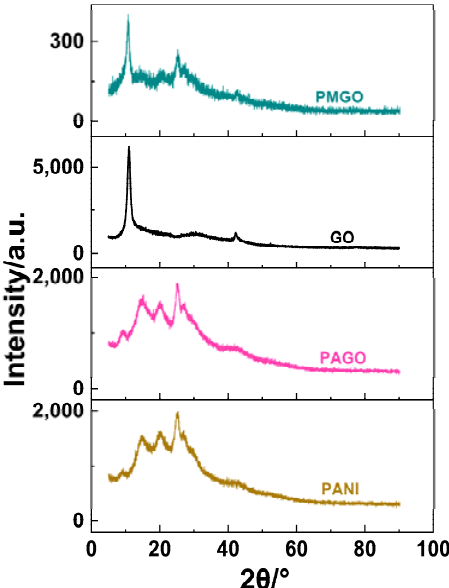
Figure 3. XRD of the synthesized powders.